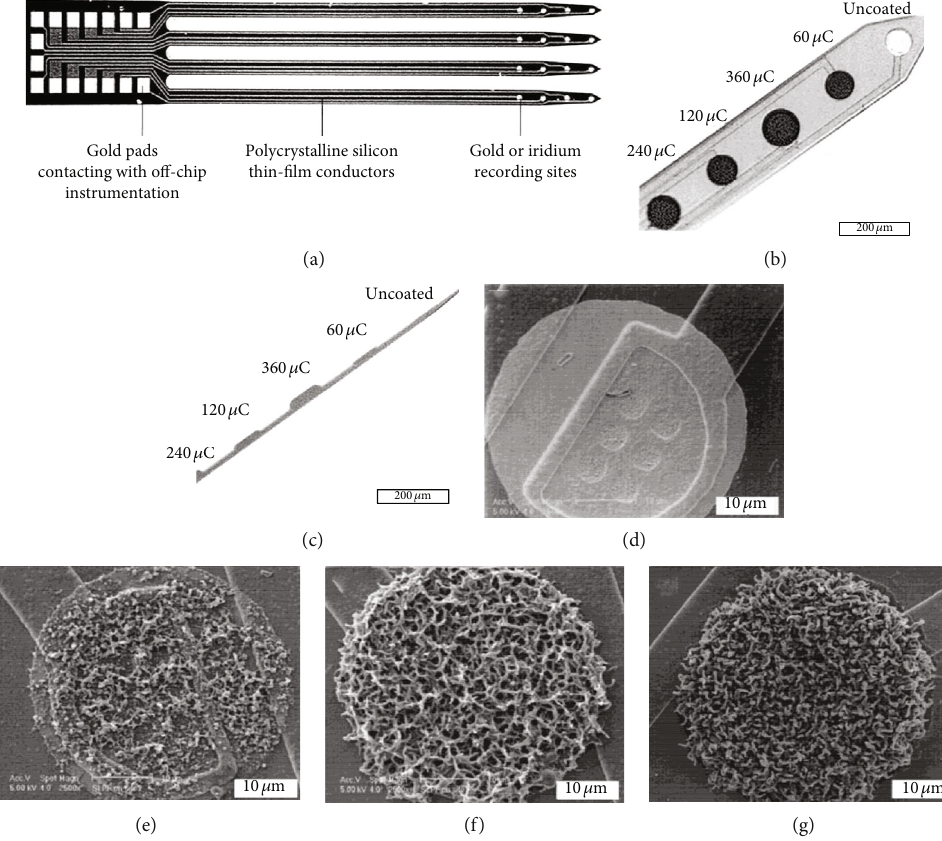
Figure 3: (a) Micromachined metal/silicon-based neural recording probe. (b, c) Optical micrographs of a PPy/PSS-coated 5-channel neural probe. (b) is the top view of the probe, and (c) is the side view from which the thickness of the fi lm can be estimated. The area of each metal electrode is 3900 μ m 2 , and the thickness of the probe is 15 μ m. By varying the deposition charge, the amount of material deposited can be precisely controlled. (d – g) SEM images of PPy/SLPF-coated electrode sites. From (d) to (g), the deposition time increased, corresponding to a total charge passed of (d) 0 μ C, (e) 1 μ C, (f) 4 μ C, and (g) 10 μ C. The area of the uncoated electrode site is 1250 μ m 2